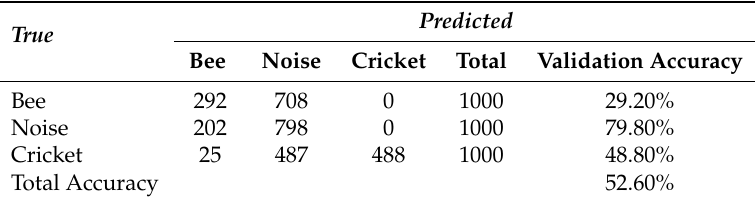
Table A16. Confusion matrix for random forests on BUZZ2 validation dataset.